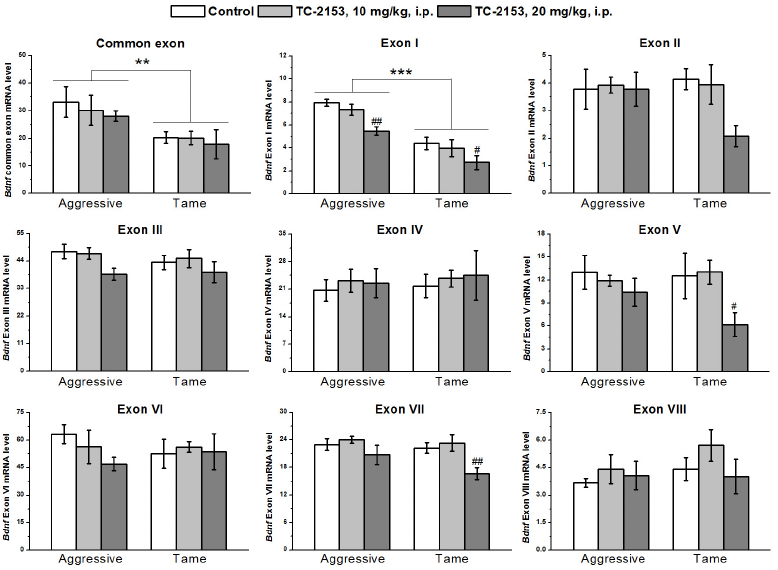
Figure 3. The impact of acute administration of vehicle (control) or TC-2153 at a dose of 10 or 20 mg/kg on mRNA levels of Bdnf (brain-derived neurotrophic factor) regulatory exons I–VIII and coding (common) exon IX in the hypothalamus of aggressive and tame rats. The expression levels were evaluated as the number of transcript copies per 100 copies of Polr2a mRNA. ** p < 0.01 and *** p < 0.001 for the genotype effect; # p < 0.05 and ## p < 0.01 in comparison with the control group (4–7 animals per group).